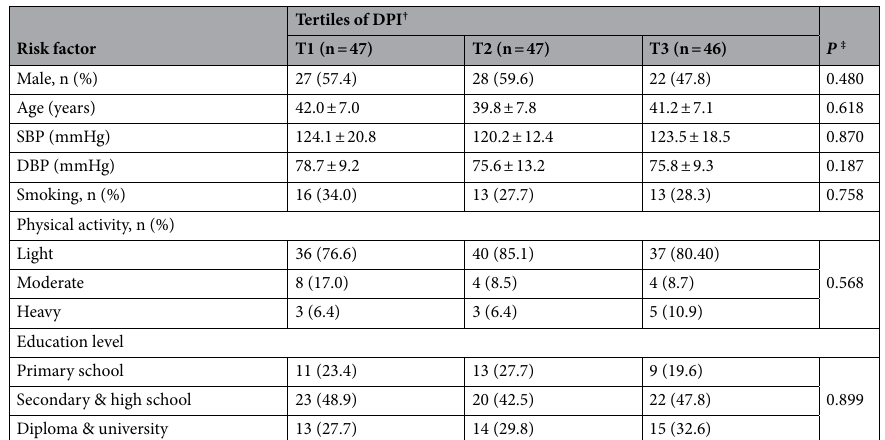
Table 1. Characteristics of subjects with obesity across tertiles of DPI. Values are expressed as mean ± standard deviation unless indicated otherwise. DPI dietary phytochemical index, BMI body mass index, WC waist circumference, SBP systolic blood pressure, DBP diastolic blood pressure. † Tertile cut-points of DPI are as follows: first tertile, < 27.3; second tertile, 27.3 to 33.9; third tertile, > 33.9. ‡ Obtained from one-way